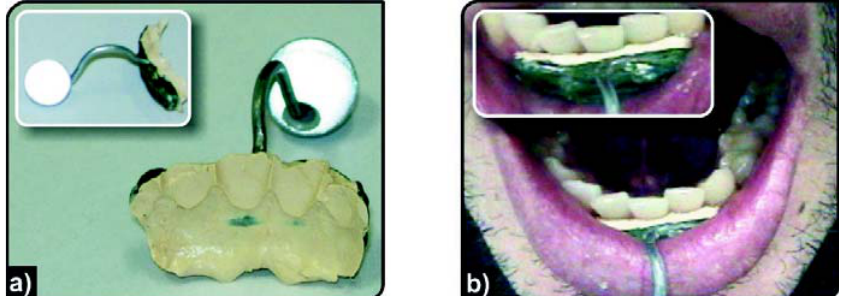
FIGURE 1- (a) Recording of mandibular movements of a subject (frontal plane). The marker support was rigidly fixed using cyanoacrylate adhesive. (b) Marker used for capturing mandibular movements. It is fixed to the mouth using a metallic stem that is supported by a fixed base. The marker reflects the light shone upon it with a high degree of